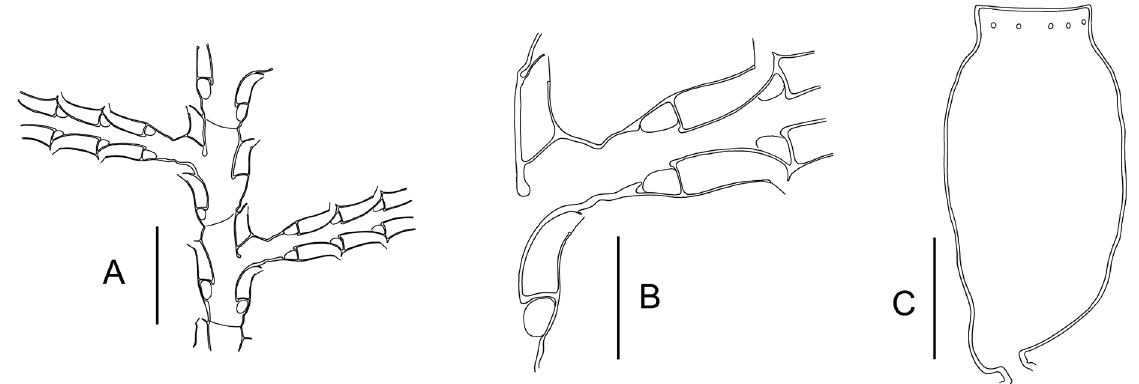
Fig. 13. Salacia sinuosa (Bale, 1888). A–C . Portion of stem with insertion of two consecutive cladia (A), axillar stem hydrotheca and basal portion of cladium (B), gonotheca (C), all from sample MNHN- IK-2015-476. Scale bars: A = 1 mm; B–C =